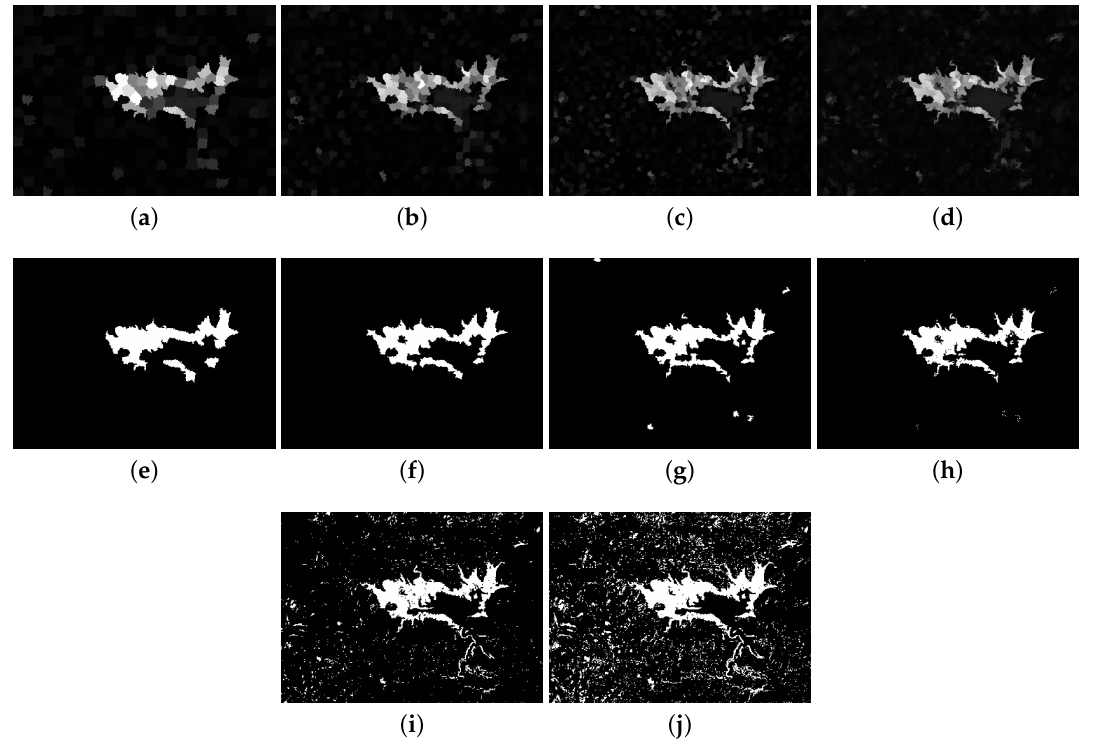
Figure 6. Results of saliency detecion and change detection for Sardinia dataset. ( a – c ): Saliency map at scale 500, 1000, 2000, respectively. ( d ) Fused saliency map. ( e – h ): Change maps by K-means on ( a – d ), respectively. ( i ): Change map by K-means on DI. ( j ): Change map by EM-Bayes.